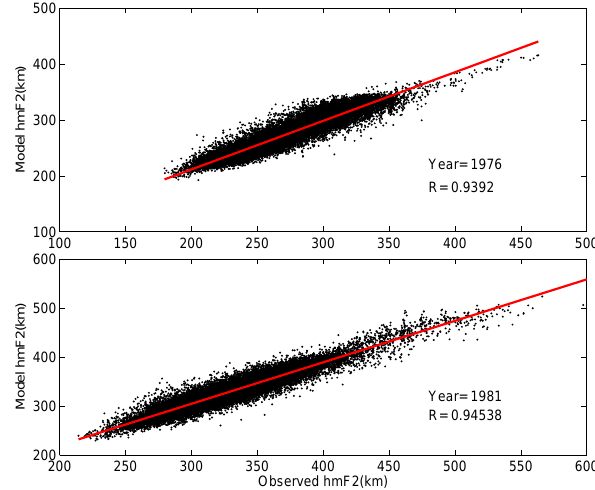
) (left panels) and – F j 1 4 ) (right panels) obtained – A j 1 4